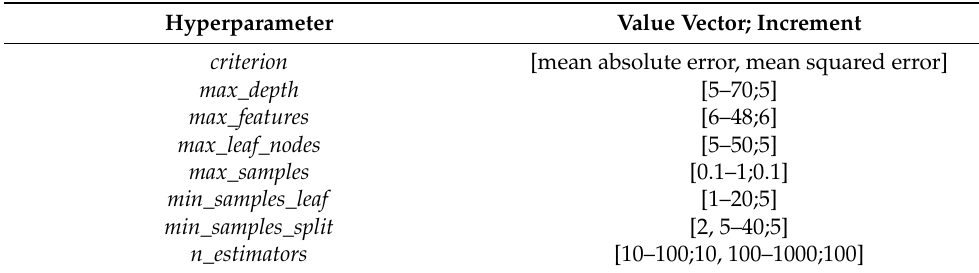
Table 2. Range of values for each hyperparameter used for the grid search